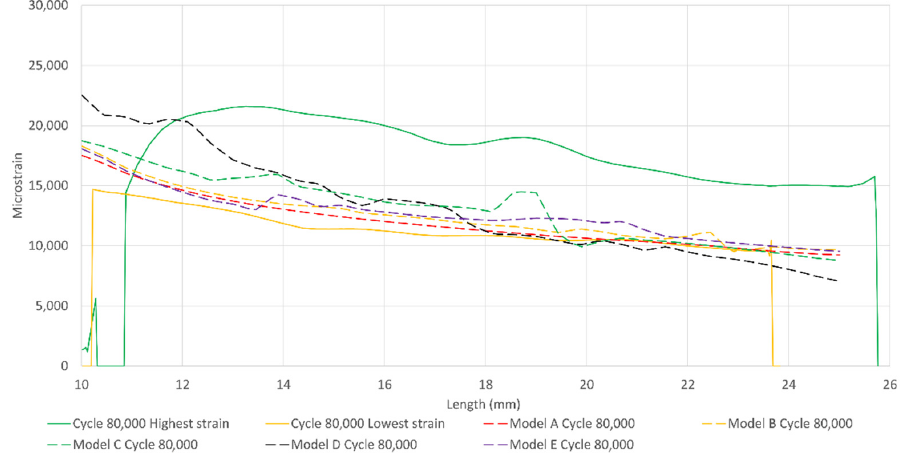
Figure 23. Lowest and highest hoop strain at 80,000 cycles from Figure 18 compared to the analy- sis sis results.